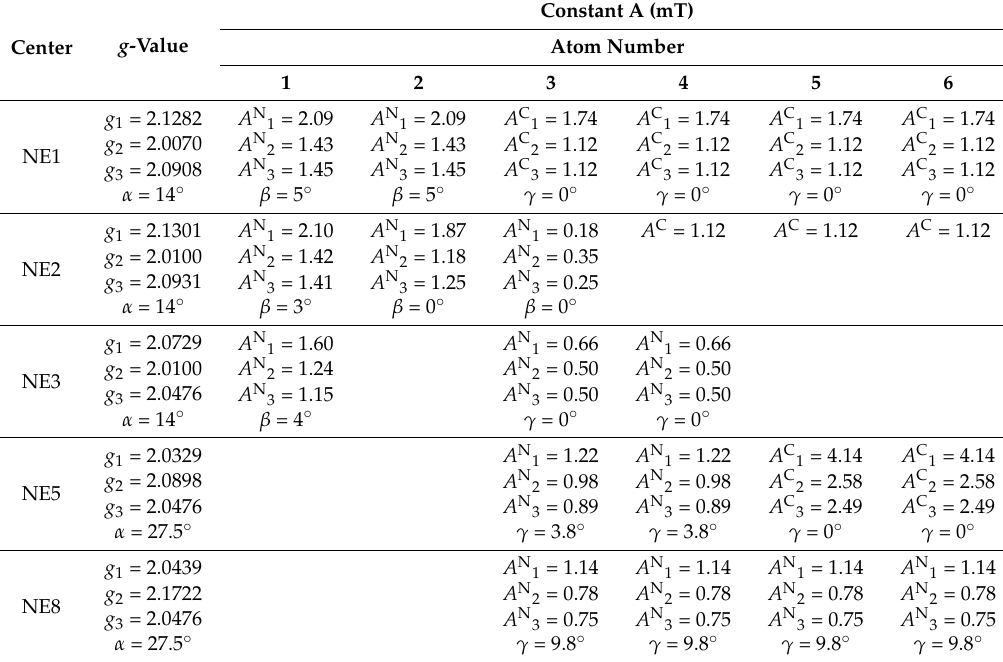
Table 1. Parameters of the spin Hamiltonian for different nickel-containing centers with S = 1/2 in diamond [19–22]. The directions are for a C 2h symmetry site with (1–10) as its plane of reflection symmetry. g 1 corresponds to (1–10), and α is the angle between g 2 and <110>. NE2 has the C 1 symmetry, and g 1 is 20 ◦ from (1–10). β is the angle between A 1 and <111>, A 3 corresponds to (1–10). γ is the angle between A 1 and (1-1-1) or (-11-1) that rotates towards (1–10), A 2 is perpendicular to the (110) plane. For the NE2 center, the hyperfine structure (HFS) from 13 C was determined unambiguously only for the (100) orientation of the crystal with respect to the magnetic